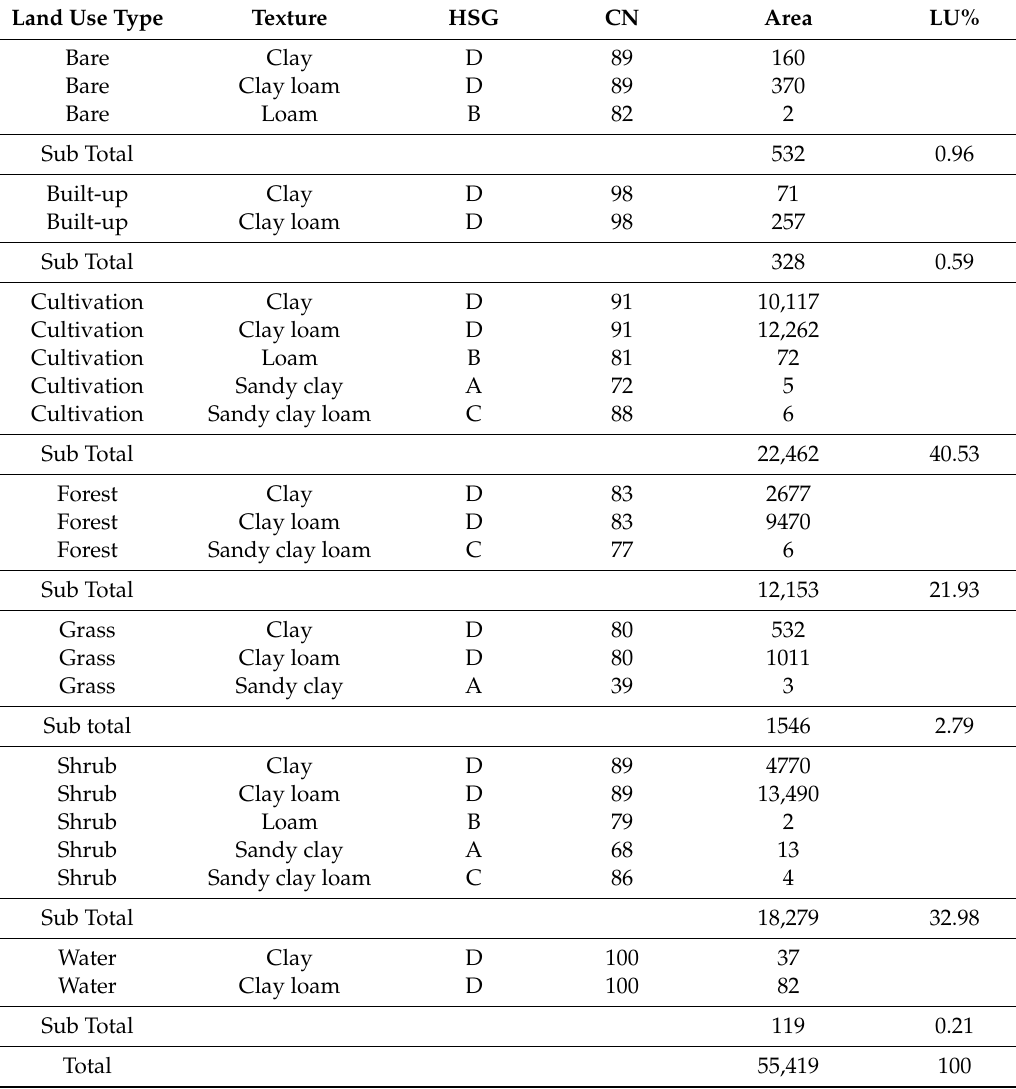
Table 4. Runo ff curve numbers for antecedent moisture condition (AMC II) for the study